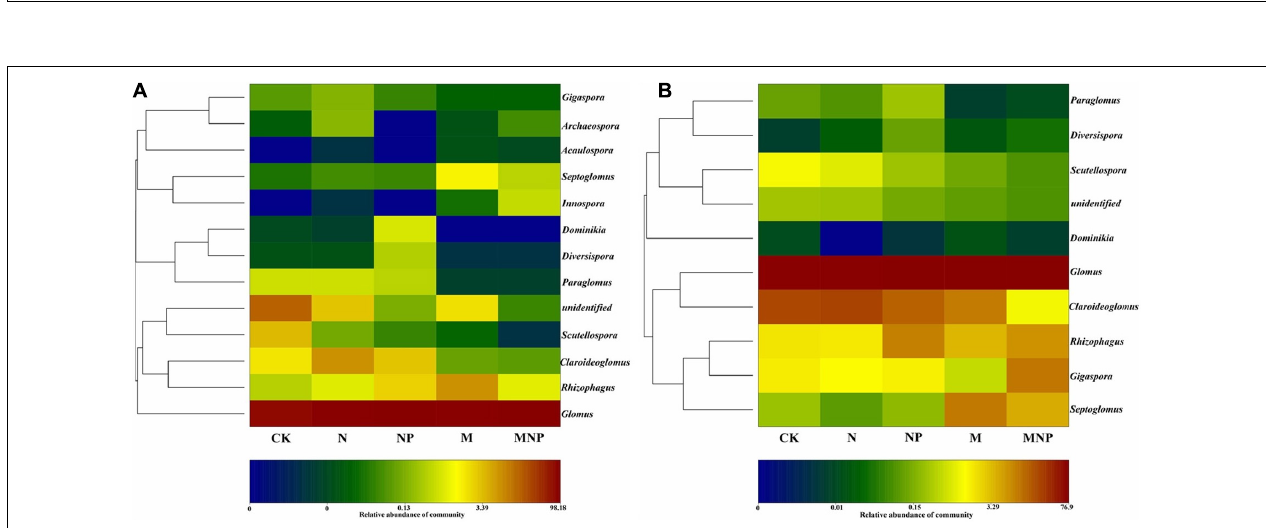
FIGURE 3 | Log-scaled percentage heatmap of AMF genus-level composition in soil (A) and roots (B) .